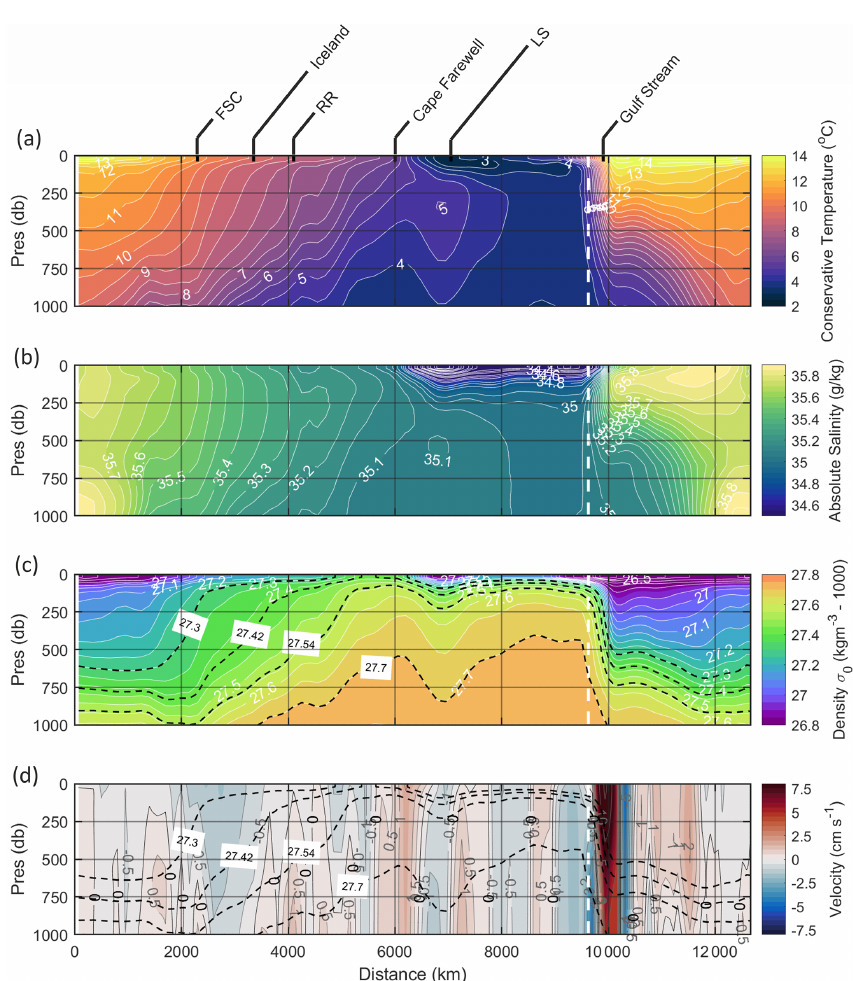
Figure 3. Gridded boundary product plotted by distance along the 1000m contour travelling anticlockwise around the basin (annual means shown): (a) conservative temperature ( ◦ C), (b) absolute salinity (gkg − 1 ) , (c) density ( σ 0 , kgm − 3 ) , and (d) geostrophic velocities across the boundary perpendicular to the 1000m depth contour (cms − 1 , positive into the interior, negative out of the interior, colour map intervals of 0.25cms − 1 with selected contours shown). Density contours relevant to overturning processes (Fig. 9) are shown by dashed black lines in (c) and (d) . The transition to the 47 ◦ N section and from gridded CTD to EN4 climatology data is delineated by the dashed white line. Key locations around the boundary are labelled: Faroe–Shetland Channel (FSC), southernmost point of Iceland, Reykjanes Ridge (RR, southern tip), Cape Farewell, the Labrador Sea (LS), and the Gulf